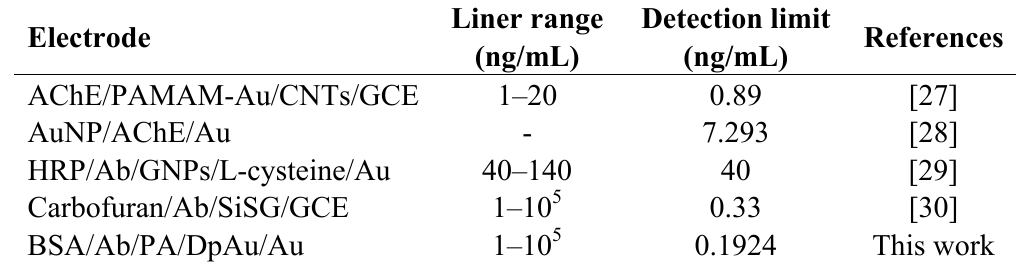
Table 1. Comparison with other reported immunosensors for the detection of